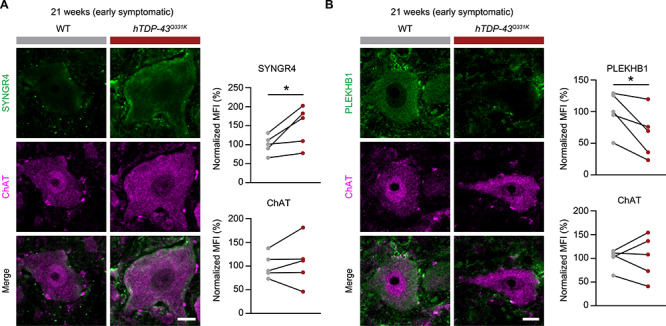
The hTDP-43Q331K ALS mouse model also shows increased SYNGR4 and decreased PLEKHB1 protein levels in spinal cord MNs early in disease. Representative immunofluorescent images of spinal cord MNs from L3–5 of hTDP-43Q331K (Q331K) or WT littermate controls are shown. All images are from 21-week-old mice. MNs were stained for SYNGR4 (A) or PLEKHB1 (B) and co-stained for ChAT as an internal control. Quantification of relative signal intensity is shown. MFI, mean fluorescence intensity. n = 5; scale bars: 10 μm; values for each genotype from each specific experiment are shown; corresponding genotype pairs from a specific replicate are linked by black lines; paired t-test; *P < 0.05.